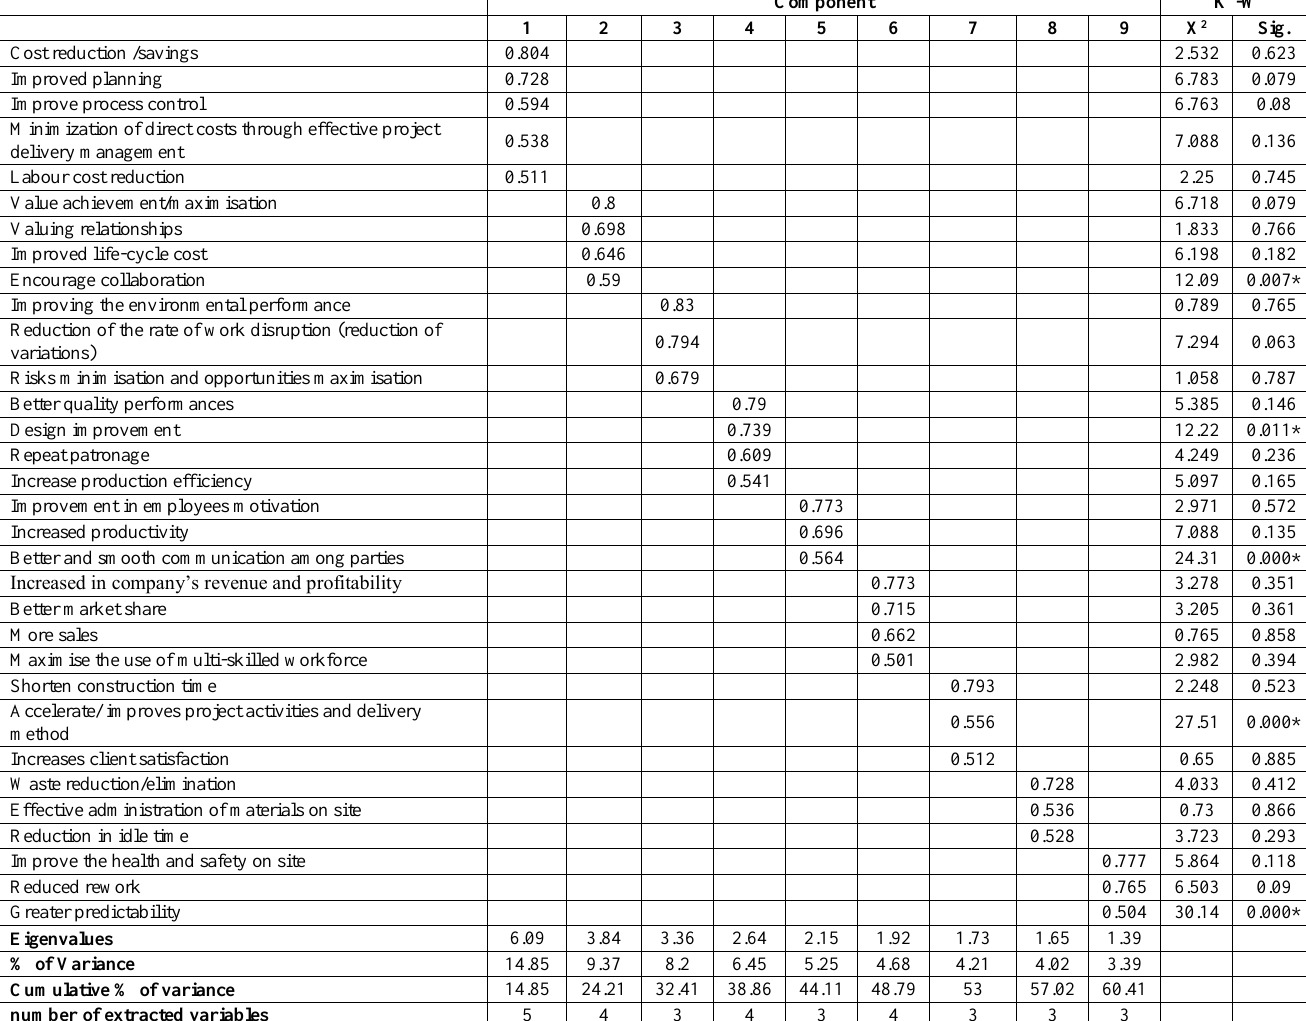
Table 2: Rotated component matrix of the benefits of lean construction.